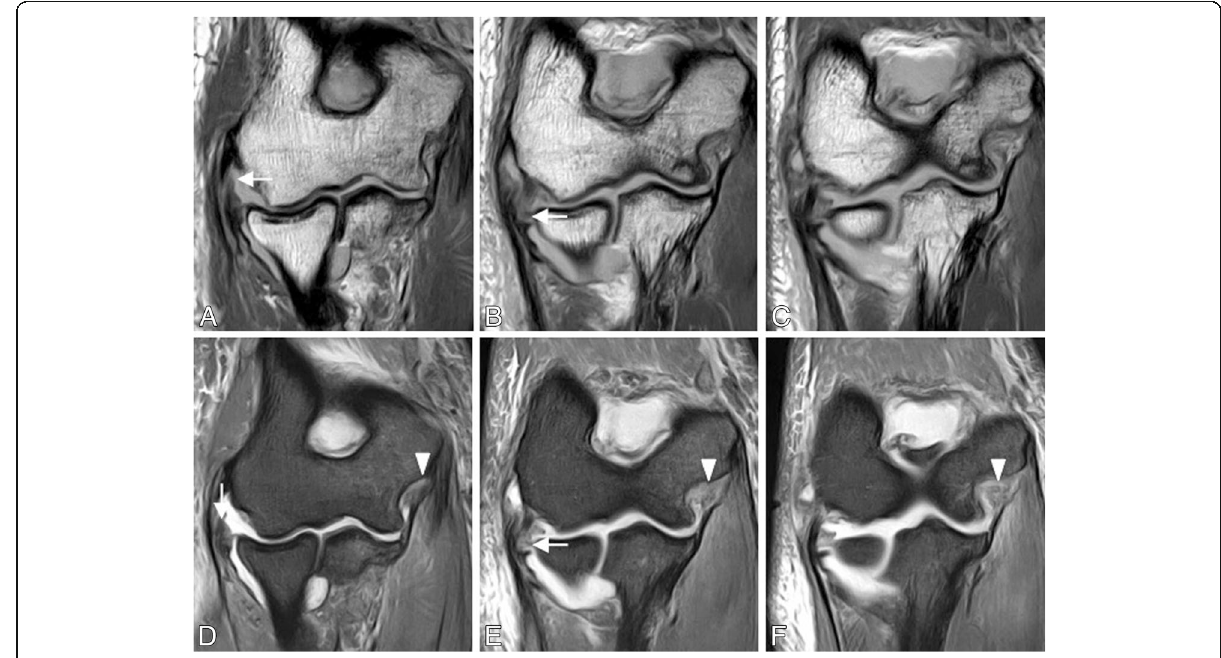
Fig. 25 Posterolateral rotatory instability, stage 3B. Consecutive coronal T1-weighted MRI ( a – c ), and consecutive coronal FS PD-weighted MRI ( d – f ) showing an acute proximal full-thickness tear of the lateral ulnar collateral ligament and radial collateral ligament (white arrows) and anterior bundle of the medial collateral ligament complex sprain (white